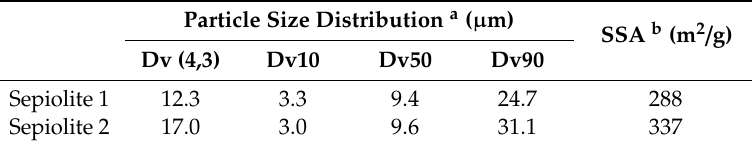
Table 2. Physical data of the sepiolite samples.